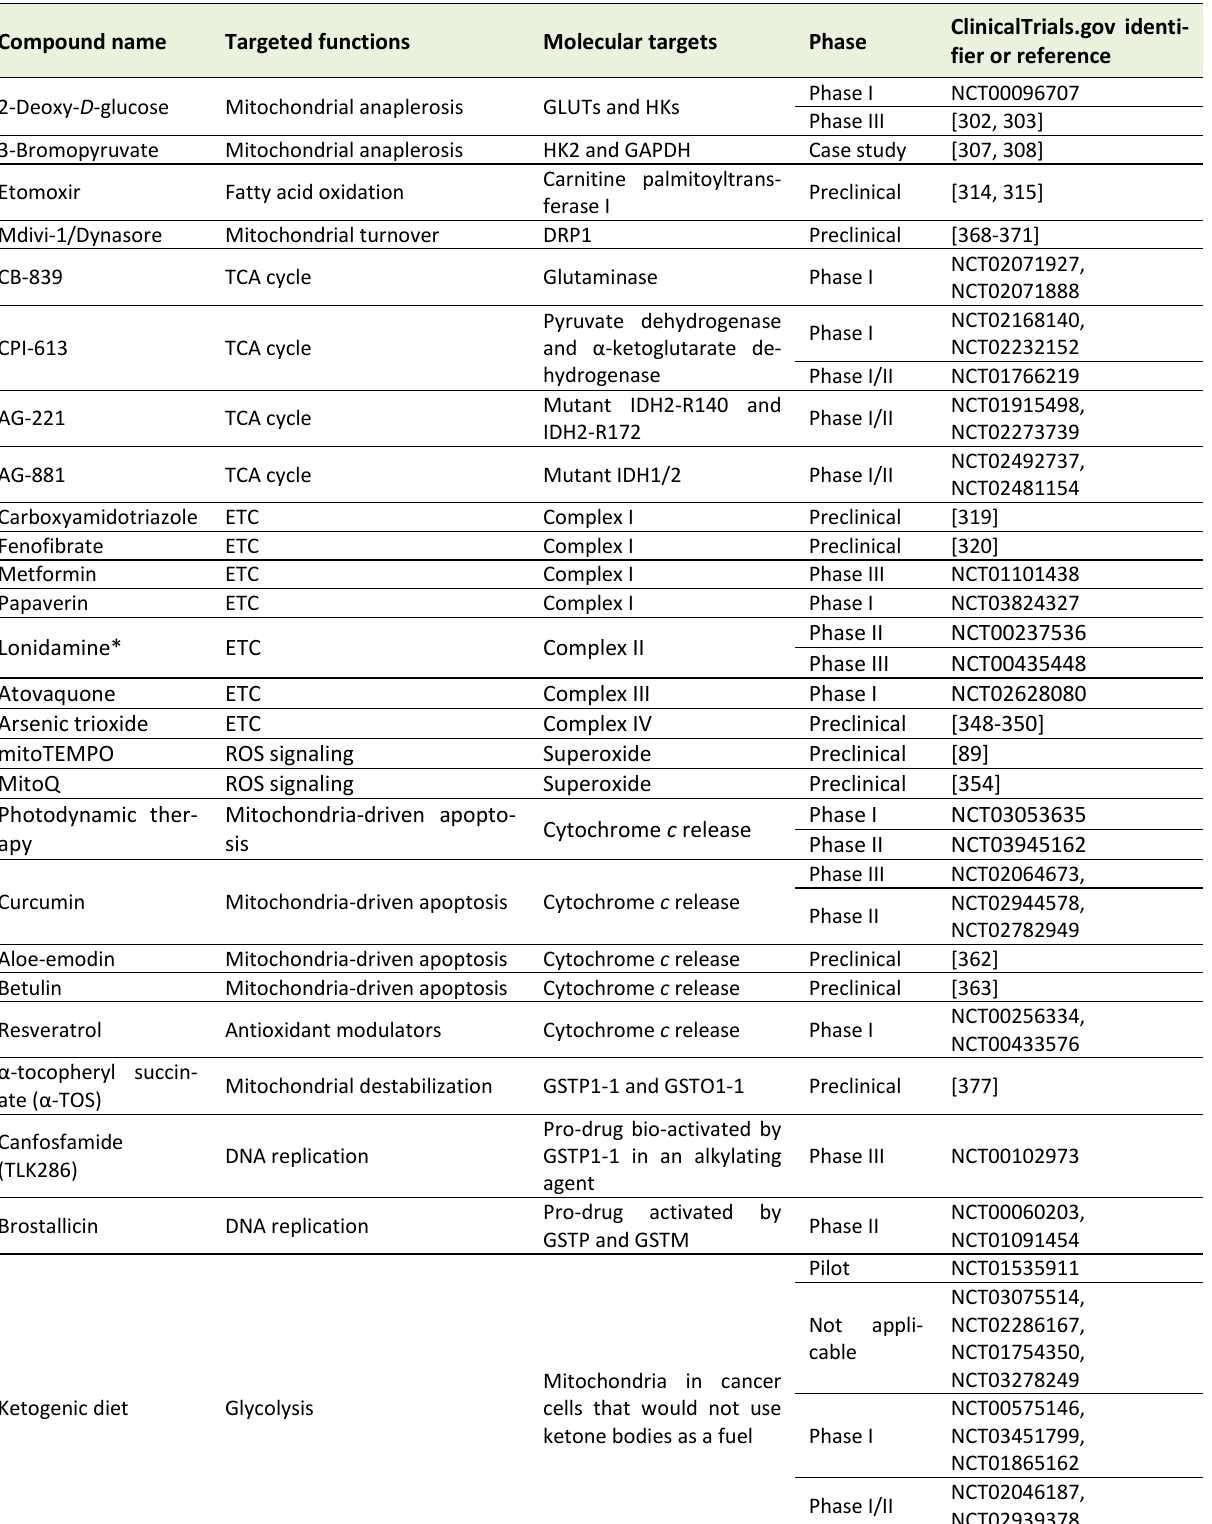
TABLE 1. Therapeutic strategies targeting mitochondria in cancer with clinical